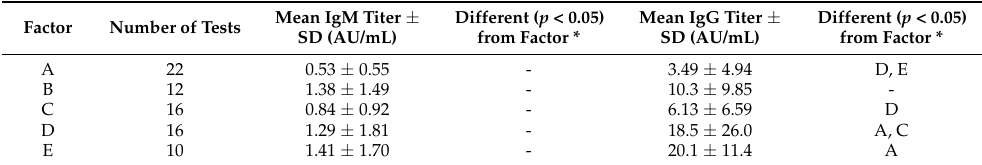
Table 5. Mean IgM and IgG titer ± SD according to clinical status of COVID-19 patients and differences between